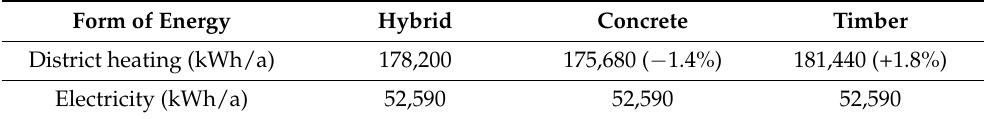
Table 2. Energy calculation results (with the difference compared with those of the hybrid apartment). Form of Energy Hybrid Concrete Timber District heating (kWh/a) 178,200 175,680 ( − 1.4%) 181,440 (+1.8%) Electricity (kWh/a) 52,590 52,590